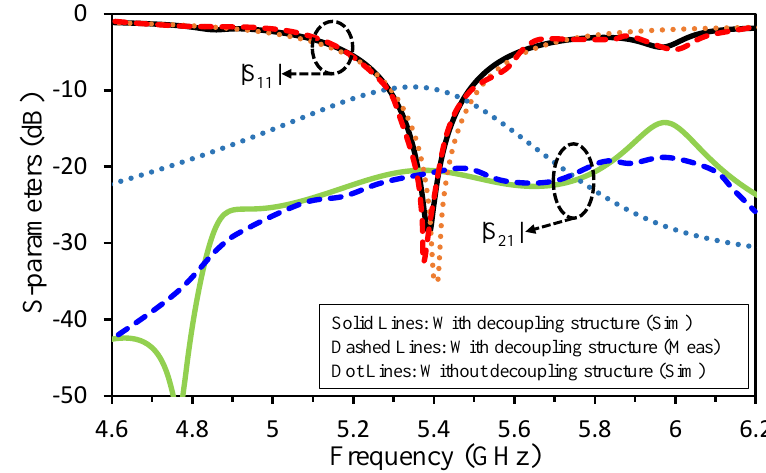
Figure 11. Simulated (with and without decoupling structure) and measured (with decoupling structure) S-parameters of the